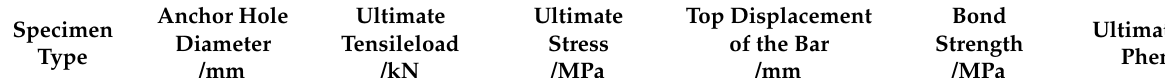
Table 8. Limit state characteristics of the bar body in the field pulling-out test.